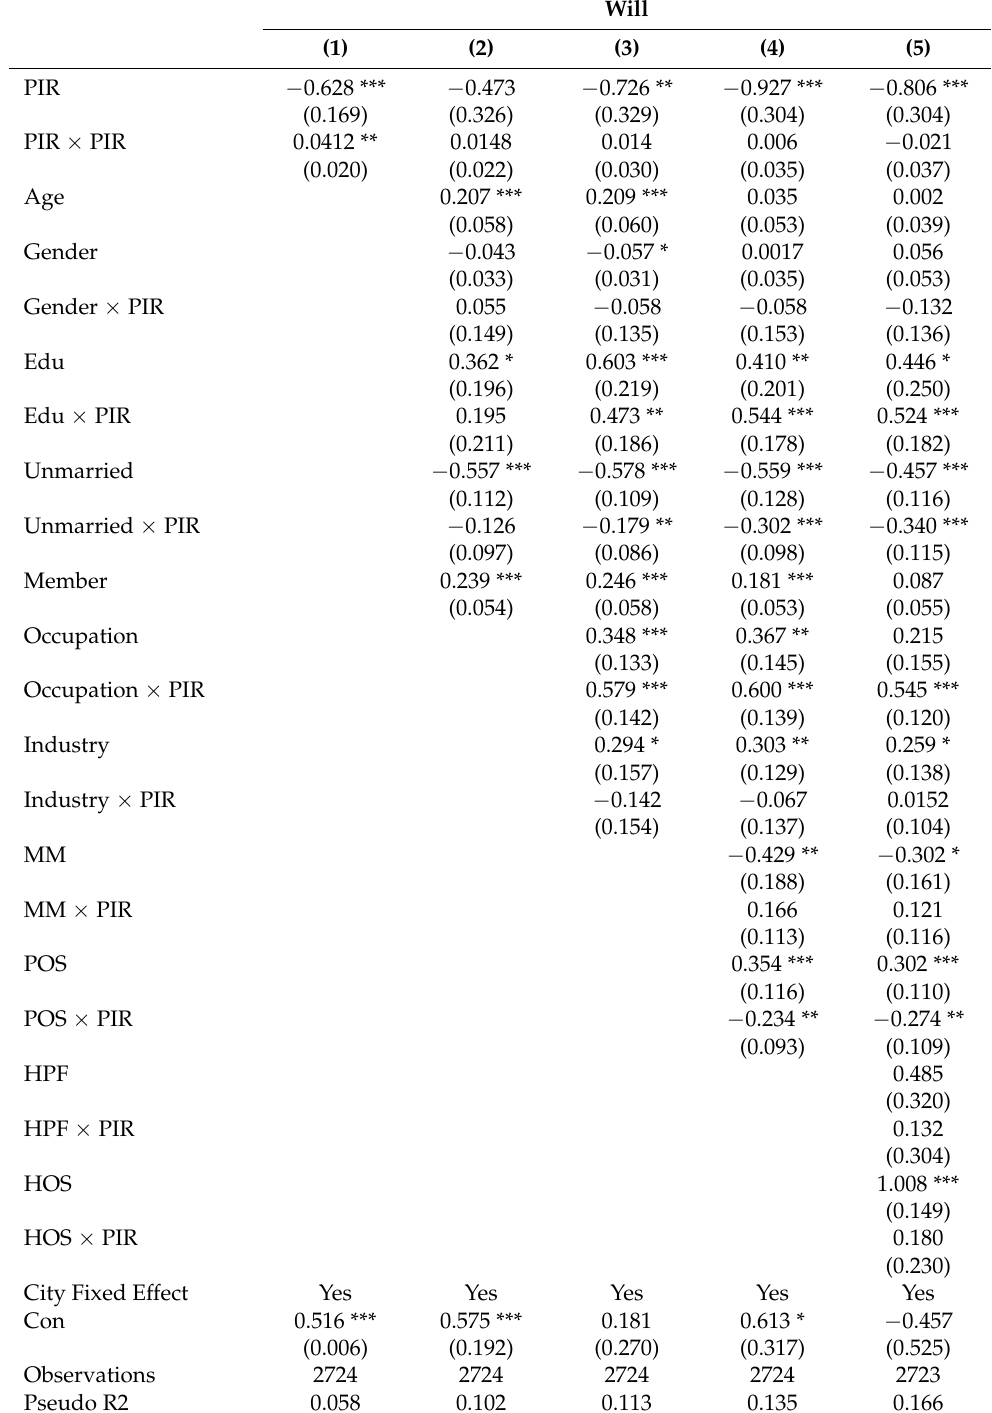
Table 2. HSYMs’ willingness to reside in a city long term, and factors influencing their tolerance for housing